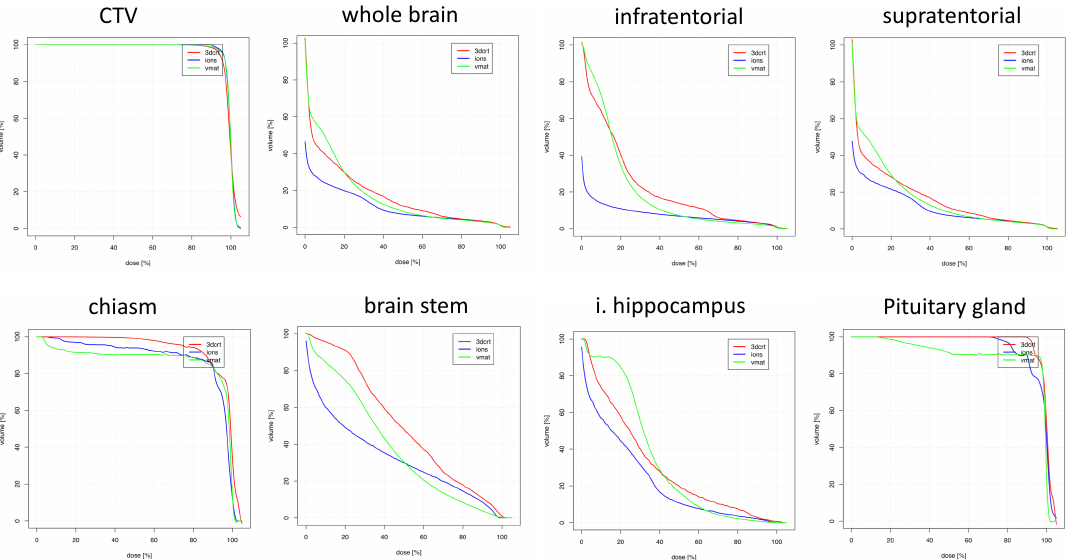
Figure 2. Dosimetric comparison: clinical target volume coverage and dose volume histogram curves of the organs-at-risk in patients with suprasellar tumor localization. Curves demonstrate median dose values of all patients with suprasellar tumor localization. Intensity-modulated proton therapy (IMPT/PRT; blue line) vs. volumetric-modulated arc therapy (VMAT; green line) vs. three-dimensional conformal radiotherapy (3DCRT; red line). CTV: clinical target volume; i.: